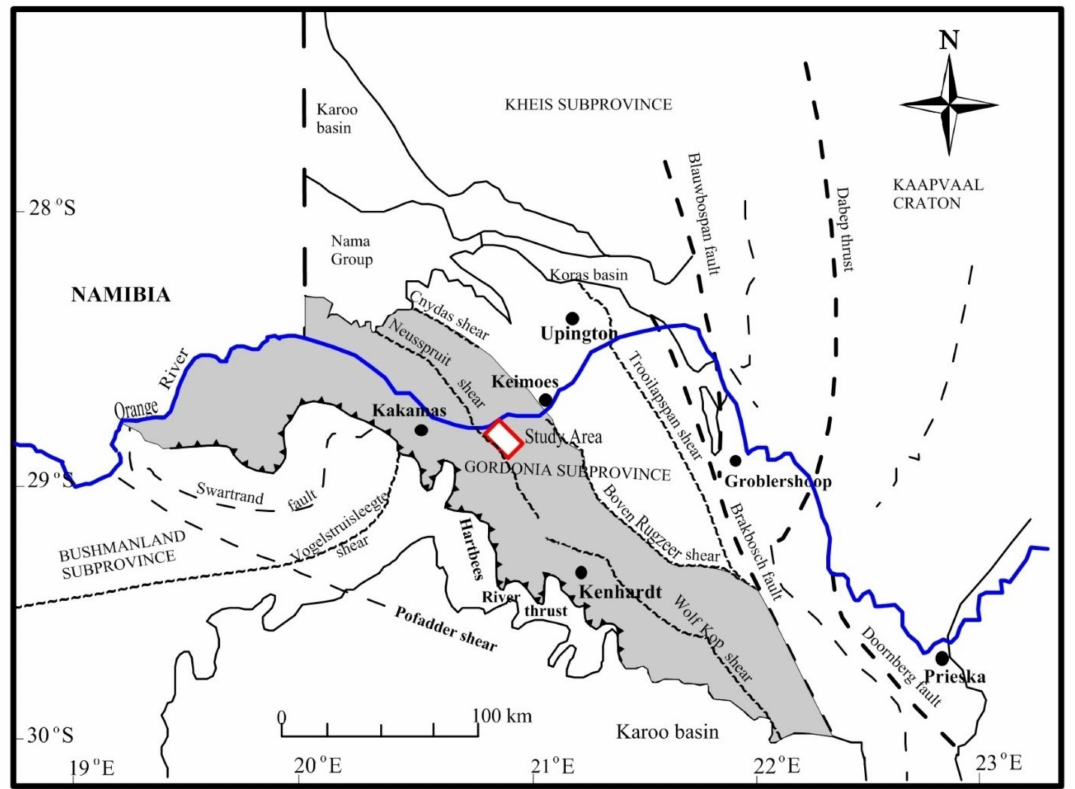
Figure 2. General distribution of major tectonic structures in the Namaqua Sector displaying Table